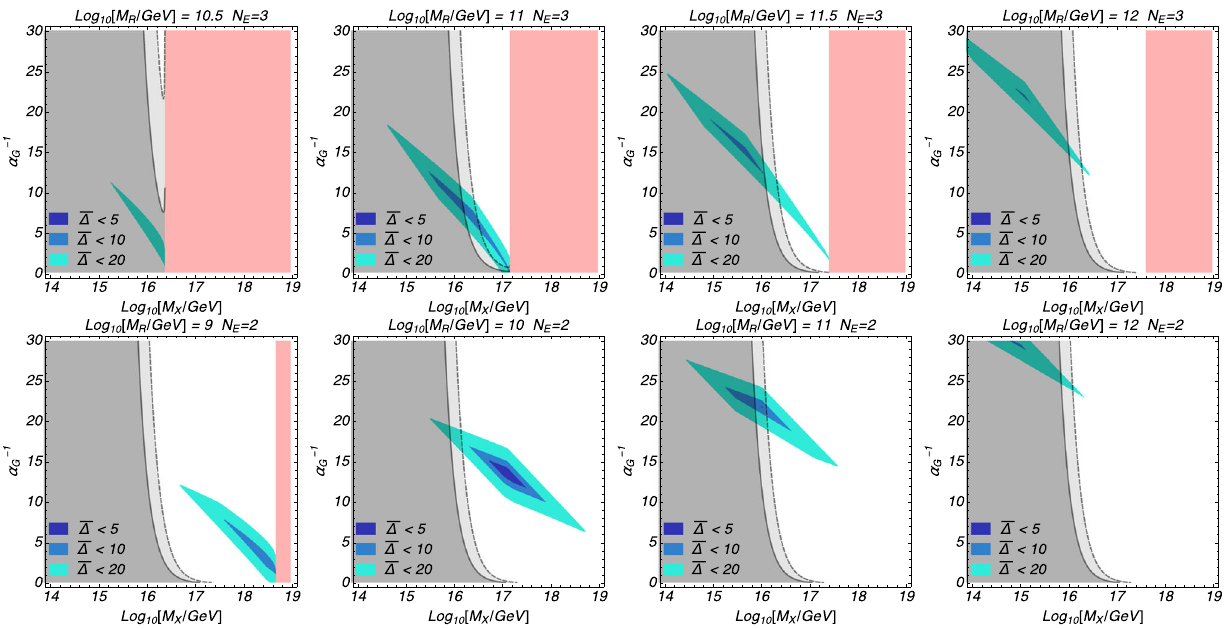
Fig. 3 The black solid and black dashed lines are proton decay con- straints on the p → π 0 e + decay mode from current SK limit and the future HK prospect. The gray shaded region is excluded by the current